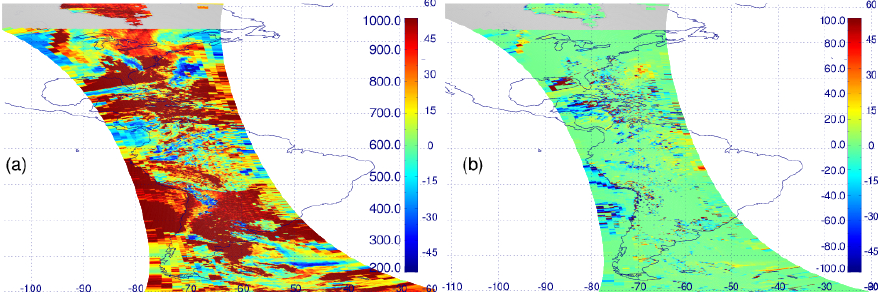
Figure 7. (a) RRS-retrieved cloud optical centroid pressure (OCP) computed with geometry-dependent LERs and (b) the difference between the OCPs computed with geometry-dependent and climatological LERs for OMI orbit 12414 of 14 November 2006.